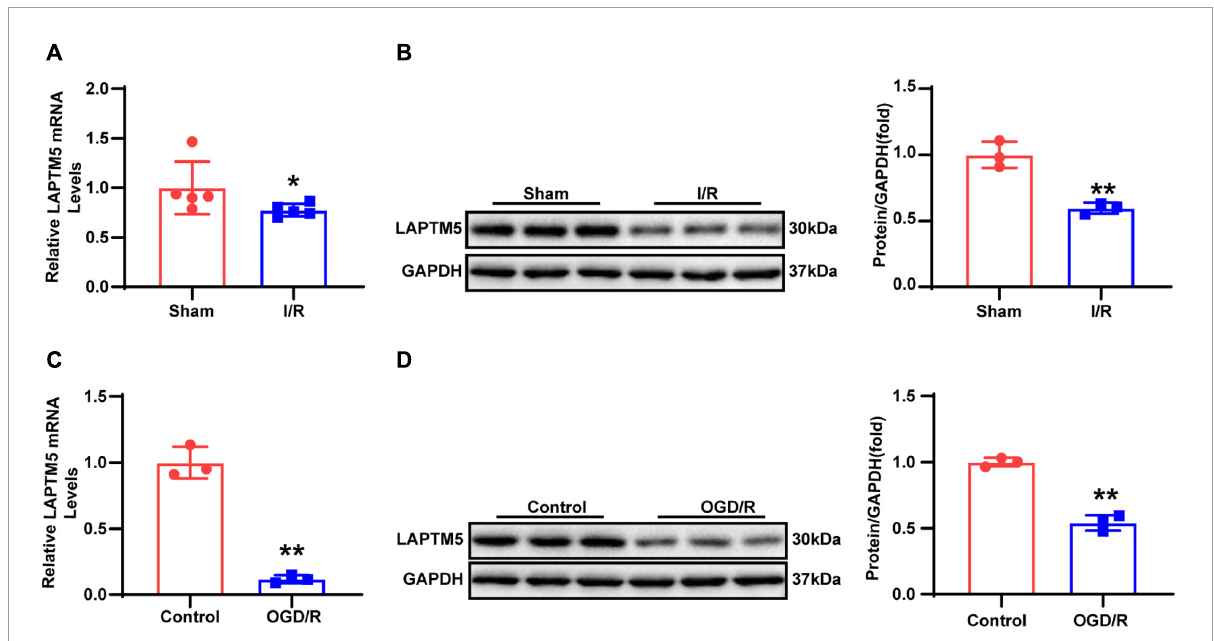
FIGURE1 LAPTM5 expression is downregulated after cerebral I/R injury. (A) The LAPTM5 mRNA levels were downregulated after 24-h reperfusion following tMCAO, n = 5 mice per group, * p < 0.05 vs. sham. (B) Western blot showed that LAPTM5 decreased after 24-h reperfusion following tMCAO, n = 3 mice per group, ** p < 0.01 vs. sham. (C) The mRNA levels of LAPTM5 were decreased in primary neurons treated with OGD for 1 h followed by reoxygenation for 24 h (OGD/R), n = 3 independent experiments, ** p < 0.01 vs. control. (D) Western blot showed lower LAPTM5 expression in primary neurons treated with OGD/R, n = 3 independent experiments, ** p < 0.01 vs.